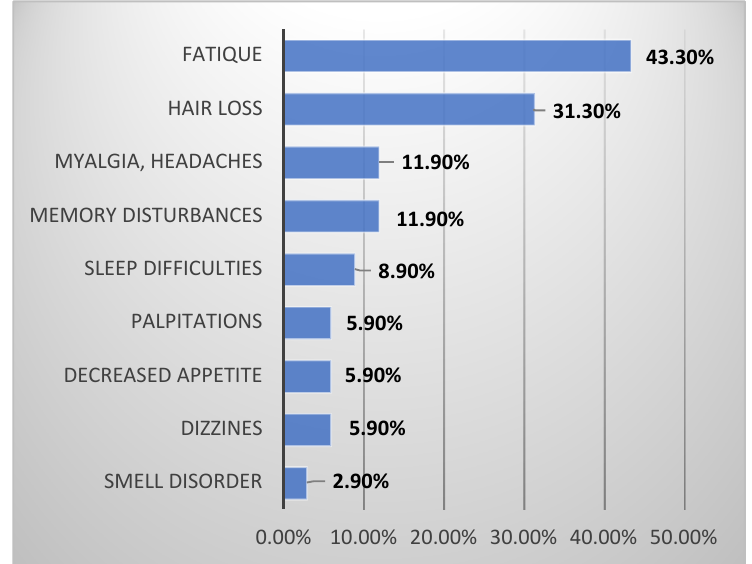
Figure 2. Self-reported symptoms in SRSQ questionnaire.